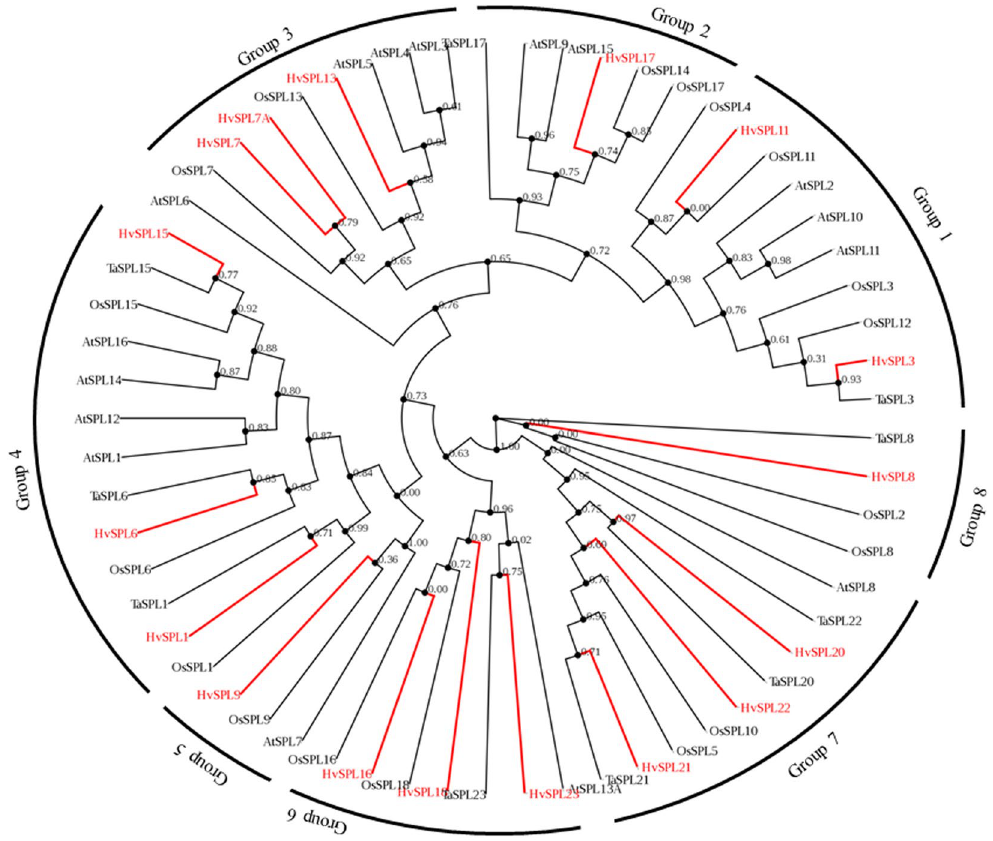
Figure 1. Phylogenetic analysis of SPL proteins based on their SBP domain sequences. The maximum likelihood phylogenetic tree of SPL proteins from Arabidopsis thaliana (AtSPL), rice (OsSPL), wheat (TaSPL) and barley (HvSPL) using PhyML3.0. HvSPLs are shown in red